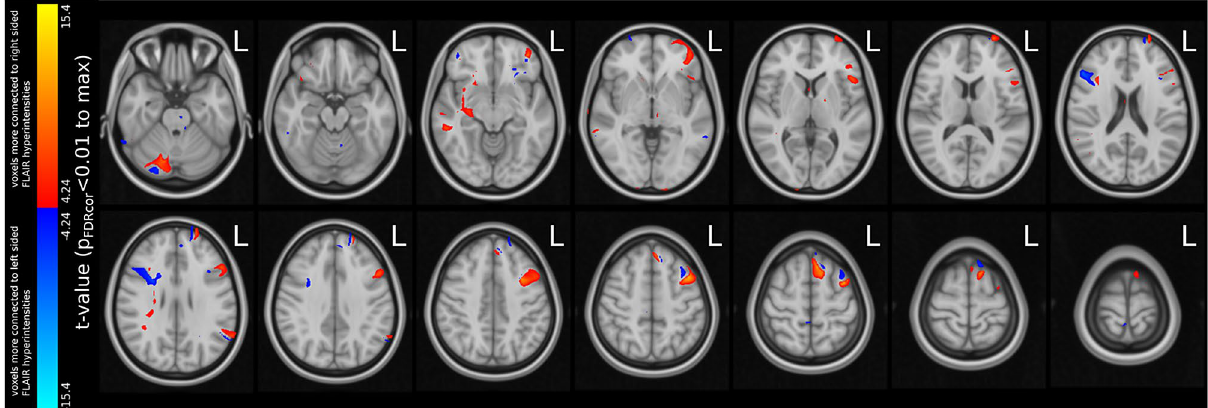
Figure 4. Comparing the ‘connectedness’ (normative connectome) of right vs left seizure focus FLAIR volumes. All colored areas—overlaid on standard brain template (MNI152)—are significantly (FDR < 0.01, i.e. 99 out of every 100 voxels is a true positive) more connected to regions of either right-sided hippocampal FLAIR hyperintensity (warm colors) or left-sided hippocampal FLAIR hyperintensity (cold